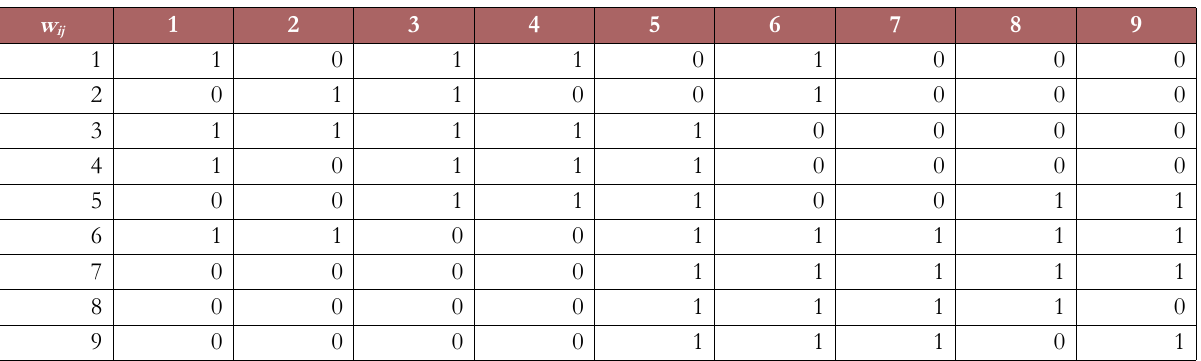
Table 1. The free trade agreement between countries